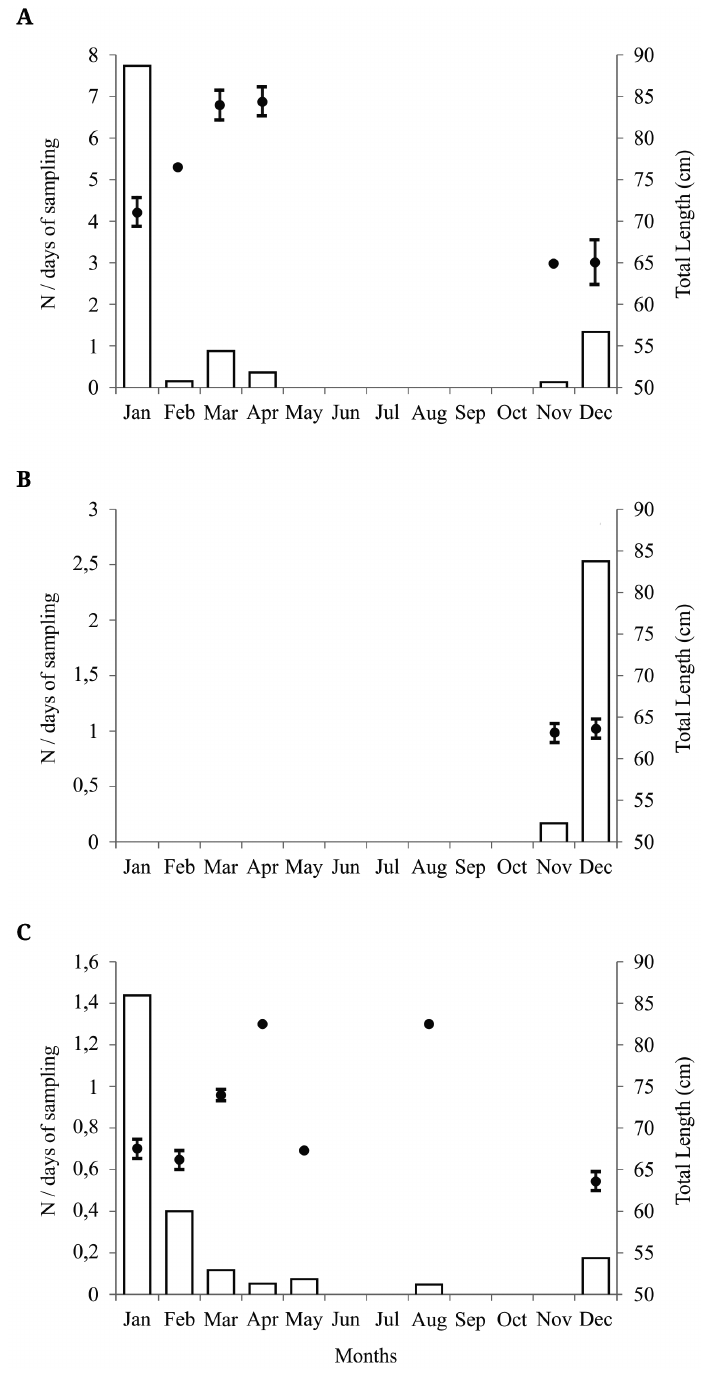
FIGURE 3 | Monthly mean daily abundance (number of individuals divided by days of sampling) and size (mean total length ± standard deviation) of neonates (< 90 cm TL) Blacktip Sharks, Carcharhinus limbatus , caught in Northeastern Brazil. A ) Ceará; B ) Rio Grande do Norte; C ) Sergipe. White bars: monthly frequency; black dots with lines: mean TL± standard